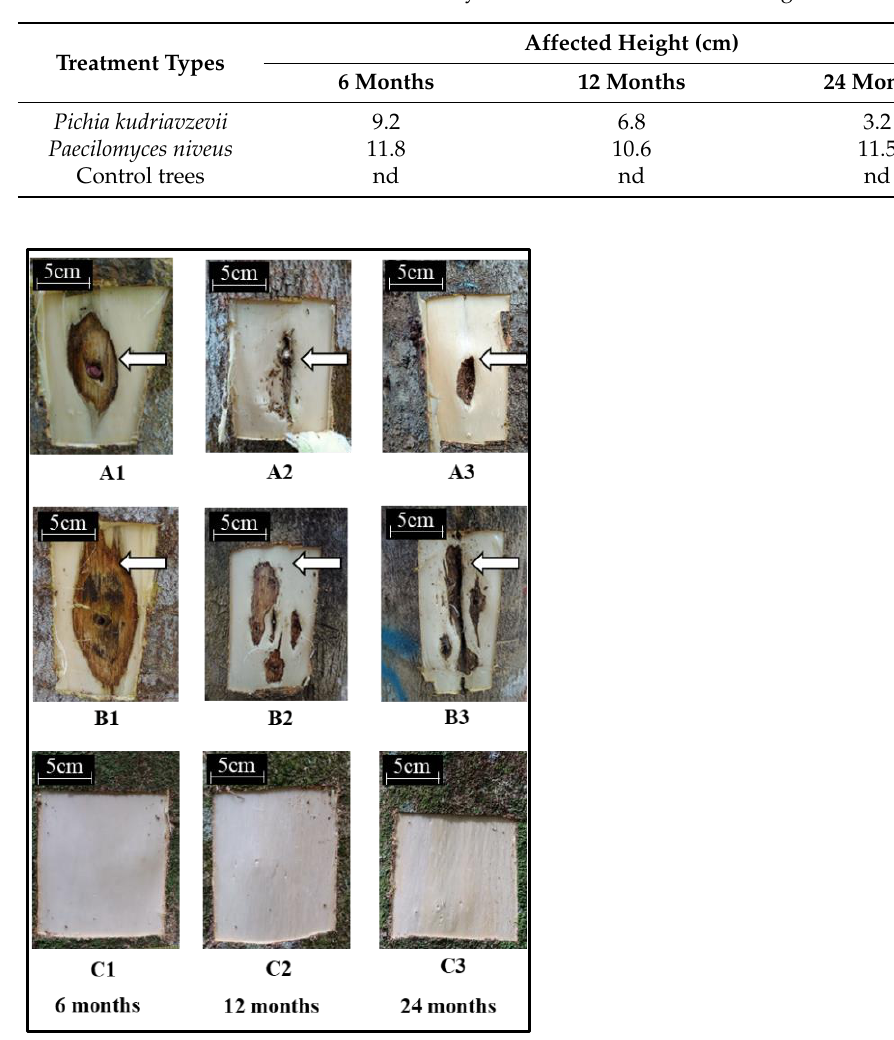
9 of 23 A Tukey multiple comparison test, for post hoc analyses, was used to confirm the differ- ences between means of multiple groups. 3. Results and Discussion This study was conducted on A. malaccensis plantation at the FRIM research station. This study visually observed the effects on the outer wood of selected inoculated and con- trol trees. A non-invasive SoT measured the areas affected by the sapwood. Further inves- tigation was conducted on the damaging effects of the interaction between inoculation types, diameter classes, and position levels within 24 months. 3.1. Visual Observation The effects of discolouration at the infected sites were observed visually by peeling the bark around the inoculation area. The size of the infected area was measured perpen- dicular to the trunk (Table 4). The infected tissue was visible on the wood surface infested by P. kudriavzevii. Discolouration on the trunk surface was observed at lengths of 9.2 cm,